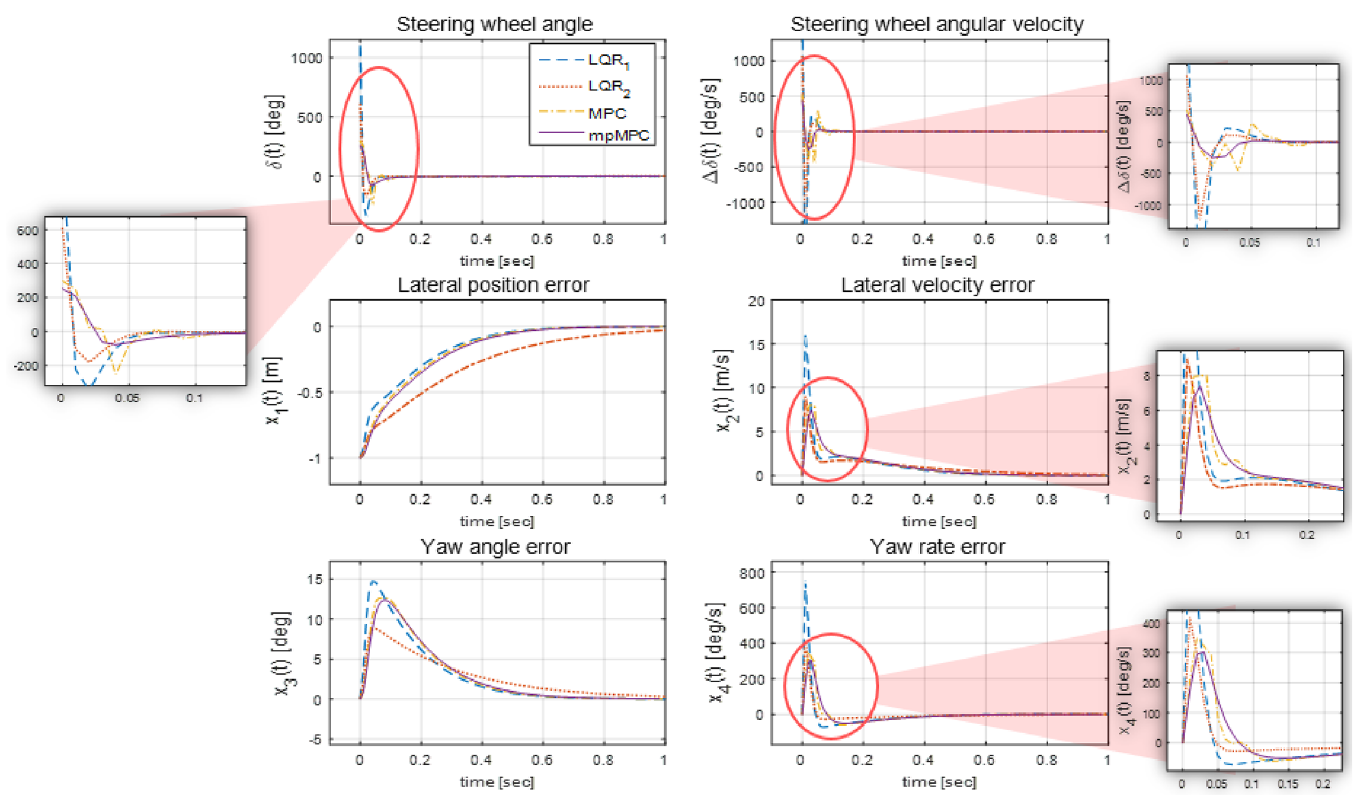
Fig 7. Comparison of optimization controllers. This figure shows the dynamics of the states of the LQR controllers, MPC controller, and explicit MPC controller. It is proved that LQR 1 cannot fulfil the constraints as set Eq (12) and that the MPC controller consumes more time than the explicit MPC controller in the first 100 simulation runs (0.51 s in the case of the explicit MPC controller and 35.71 s in the case of the MPC controller). Moreover, LQR 2 is designed to limit the maximum values of the state dynamics in the constraints by adjusting the weighting matrices; nevertheless, a high steering wheel angular velocity, which reduces ride comfort,